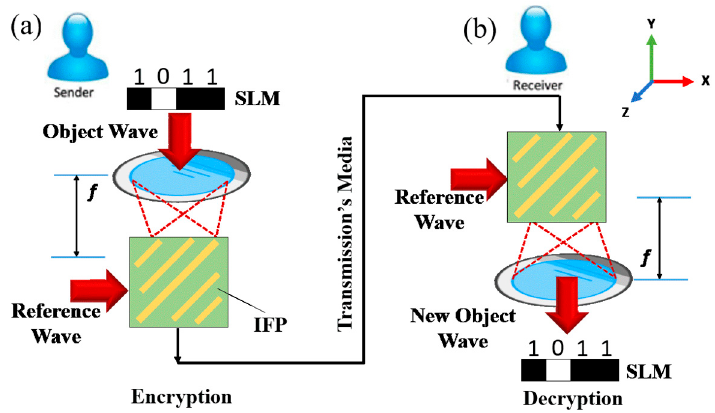
Figure 1. Model of the virtual optical holographic encryption (VOHE) system. ( a ) Encryption process; ( b ) Decryption process.